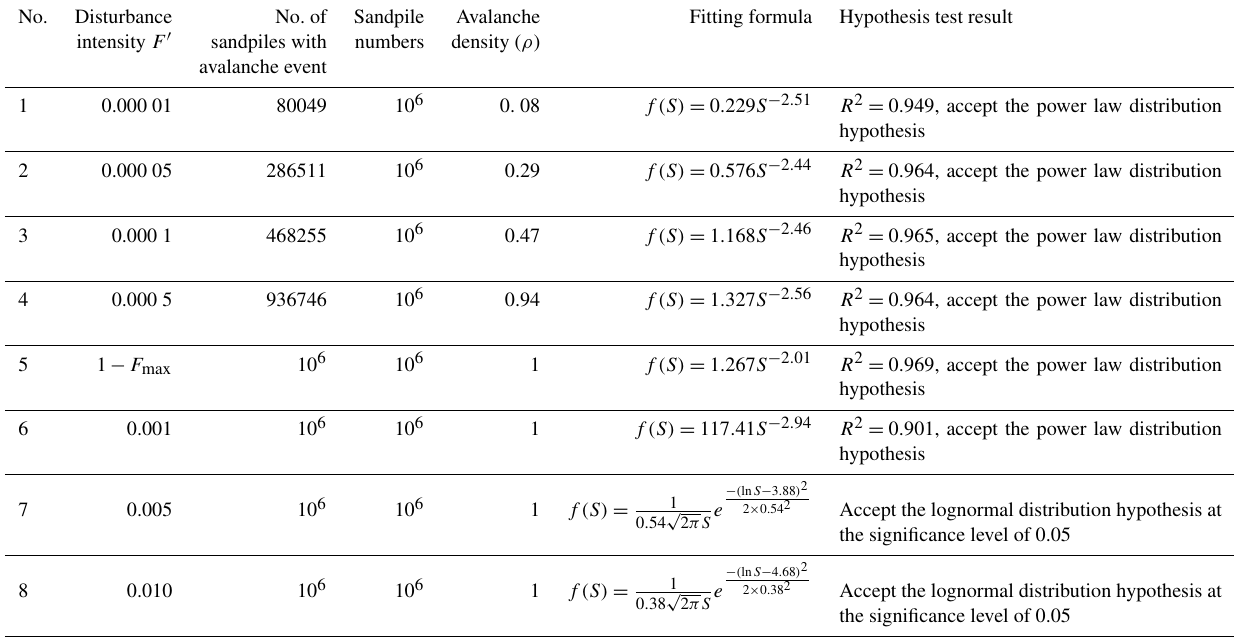
Table 4. Results of cellular automata